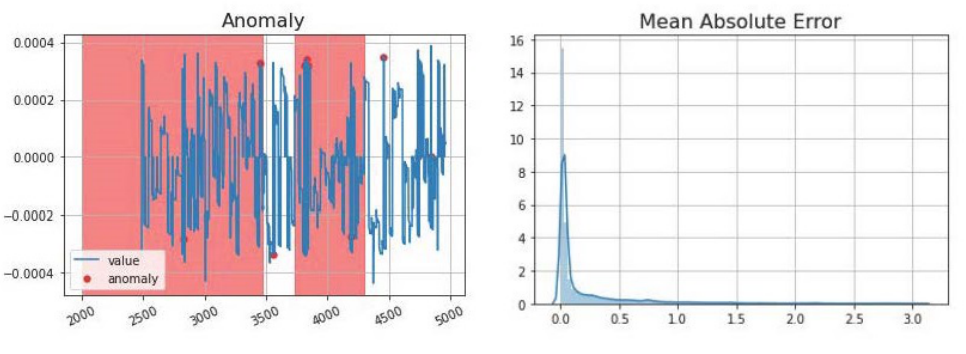
Figure 9. ( left ) R1-PA4:IH detected anomalies, and ( right ) Anomaly detection Mean Absolute